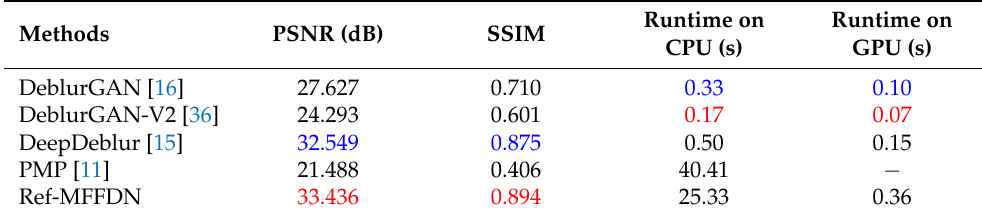
Table 2. Average PSNR, SSIM and Runtime of different deblurring methods. The highest score is highlighted in red while the second-highest score is highlighted in blue.